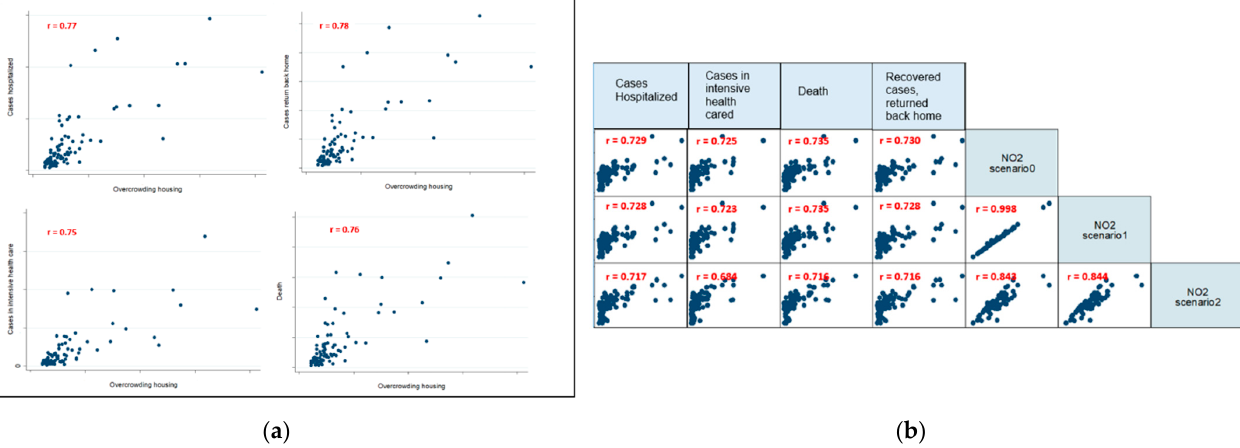
Figure 4. Correlation between health events that are COVID ‐ 19 ‐ related and deprived living conditions ( a ), long ‐ term NO 2 indicators ( b ). Table 1. Coefficient estimate of linear regression adjusted on the proportion of population aged over 60 years old.